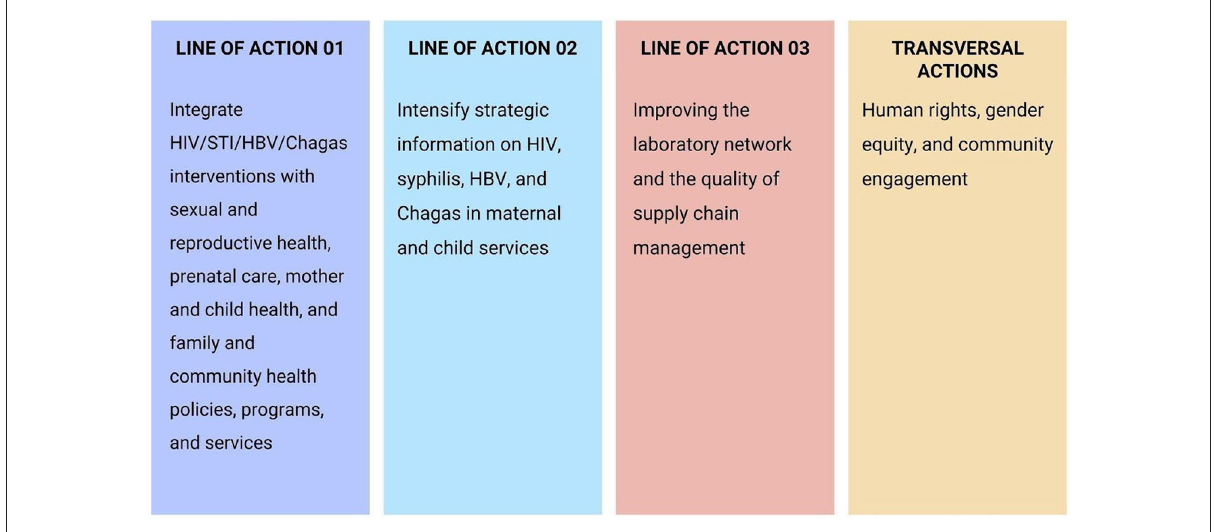
FIGURE2 Framework for the Elimination of MTCT of HIV, Syphilis, Hepatitis B, and Chagas. Source: Adapted from PAHO